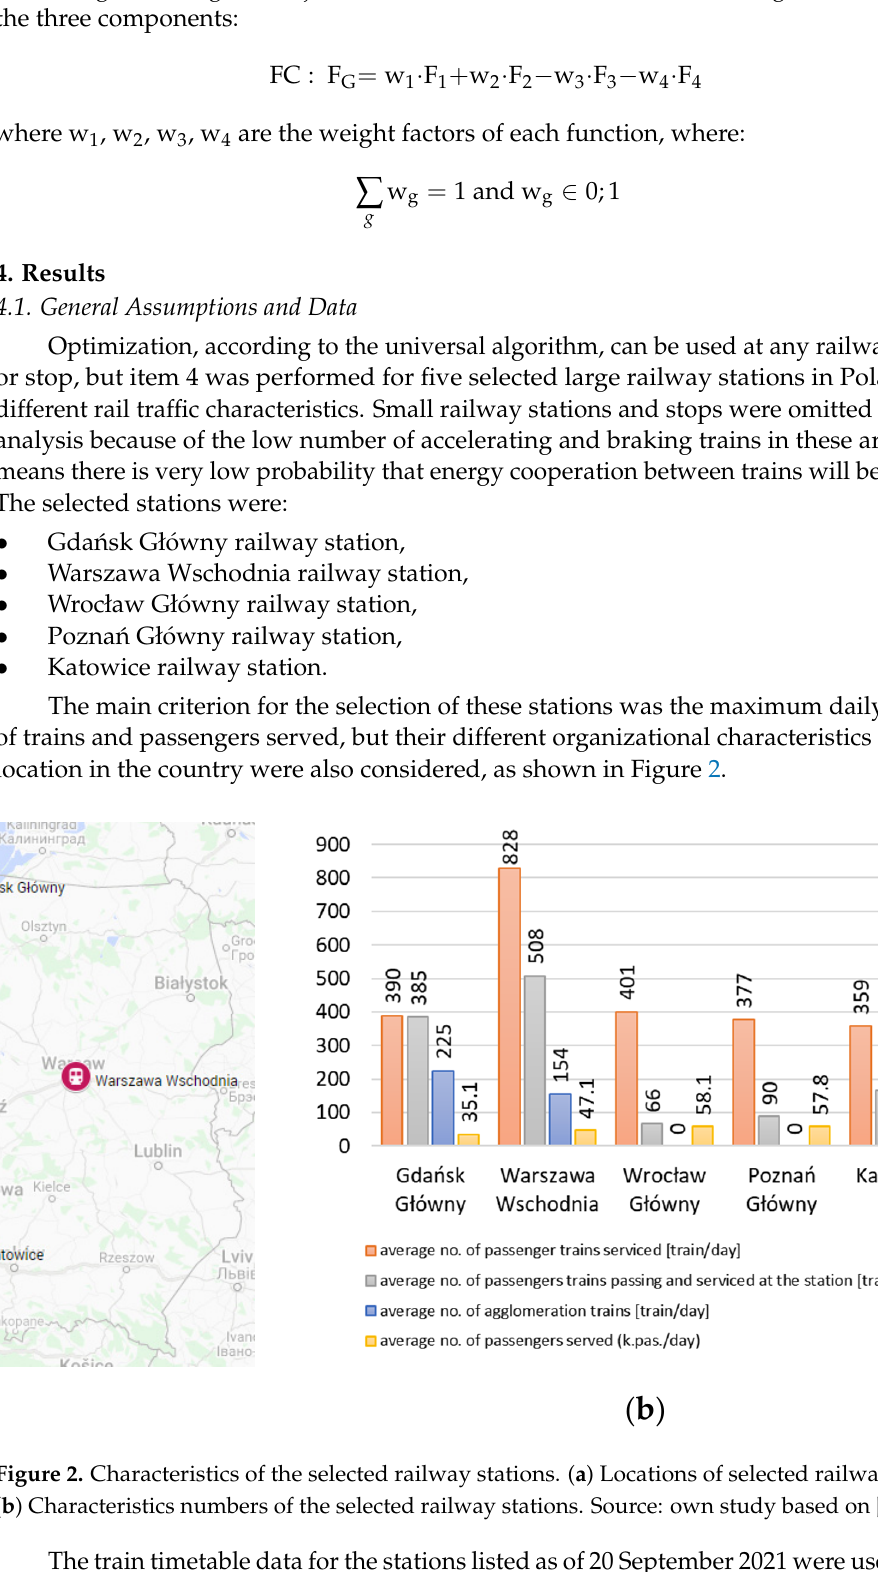
→min (23) The global weighted objective function was taken down as the weighted difference of the three components: